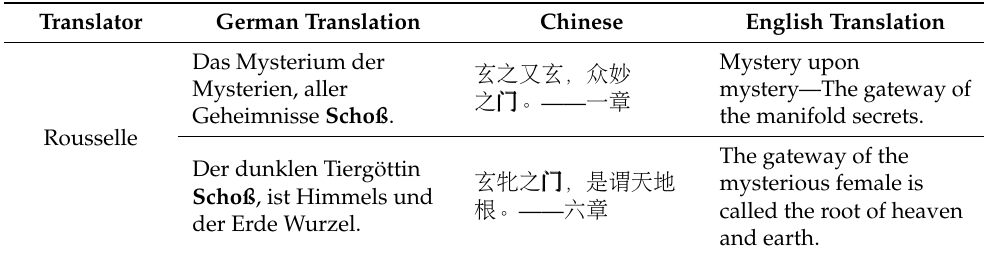
Mystery upon mystery—The gateway of 之 门门门 。 —— 一 章 the manifold secrets. The gateway of the mysterious female is 根 。 —— 六 章 called the root of heaven and